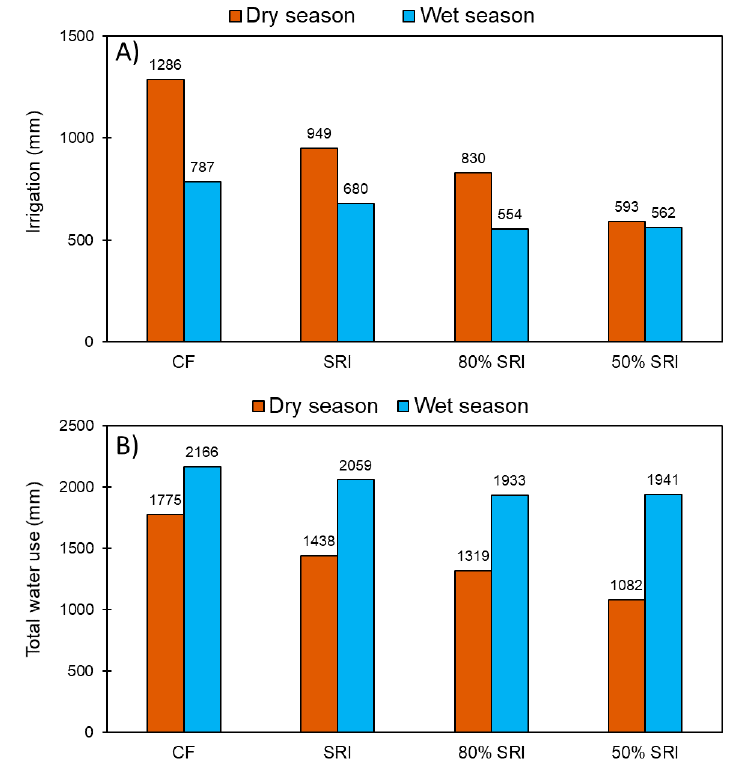
Figure 7. ( A ) Irrigation applied and ( B ) total water (irrigation + rainfall) input for continuous flood (CF), system of rice intensification (SRI), 80% SRI and 50% SRI treatments during the dry and wet seasons. 80% SRI and 50% SRI refers to 80% and 50% of the SRI ponding depth, respectively.